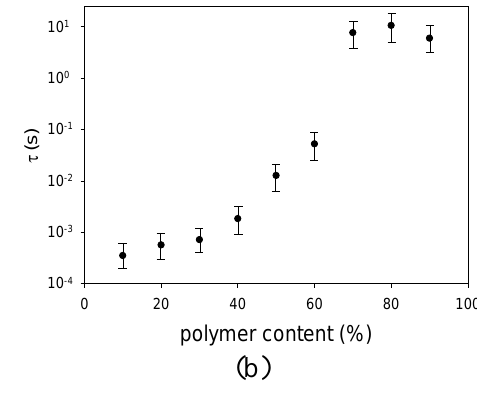
Figure 8. ( a ) Normalized pressure response of PCPSP*. ( b ) Relationship between the time response,  (s), and the polymer content